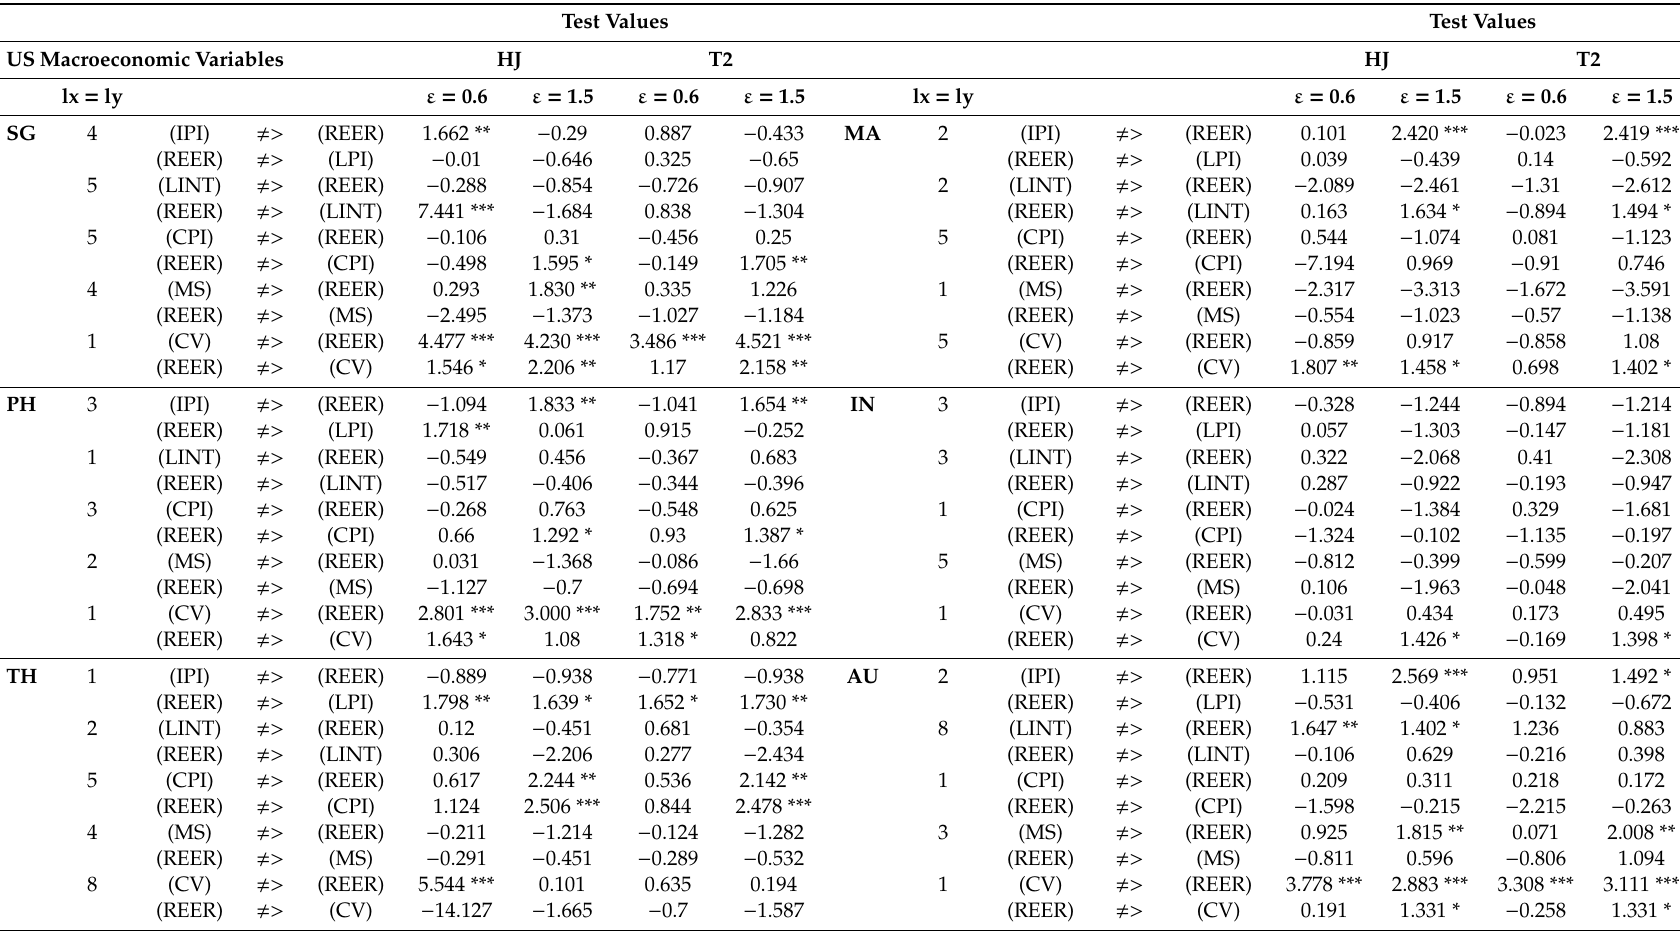
Table 10. Pairwise non-linear causality test between REERs and the US macroeconomic variables: January 1998–April 2017. Test Values Test